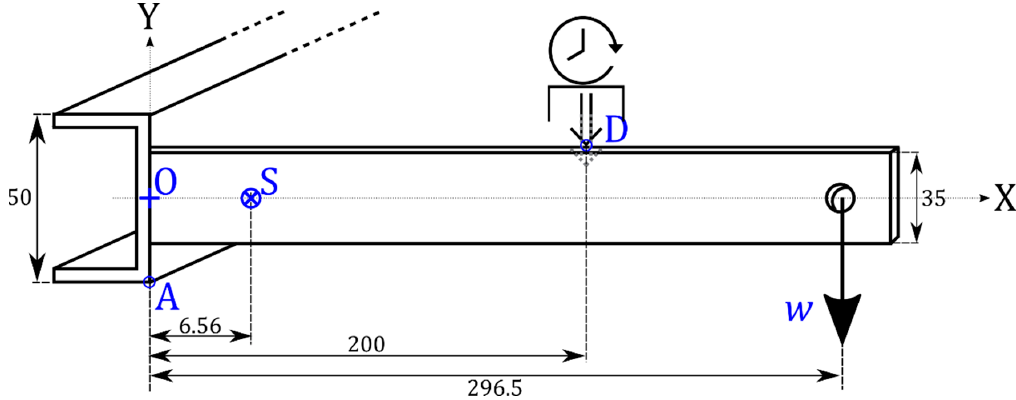
Figure 6. Scheme of the lab experiment to measure the torsion and bending of a cantilever steel beam. The units of distances drawn are millimeters.